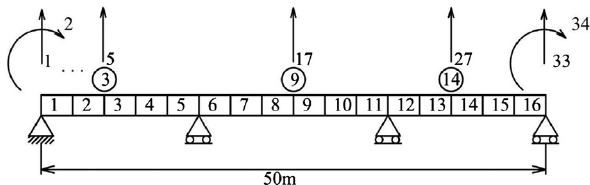
Fig. 2 Three-span continuous beam/cm calculated by model modification